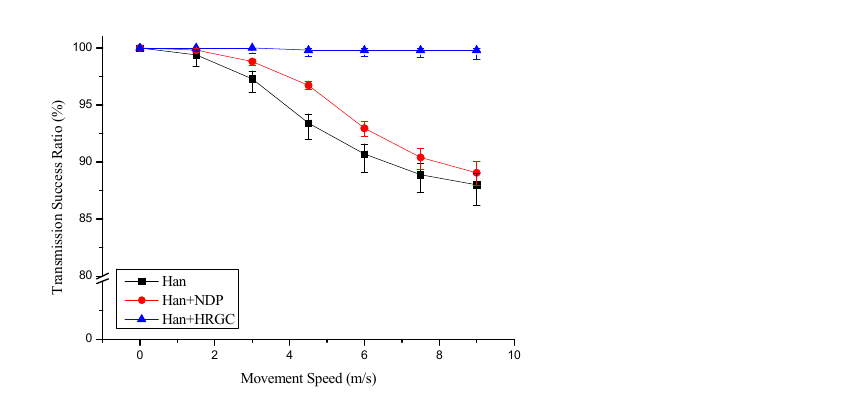
Figure 6. Transmission success ratio vs. movement speed of mobile devices.